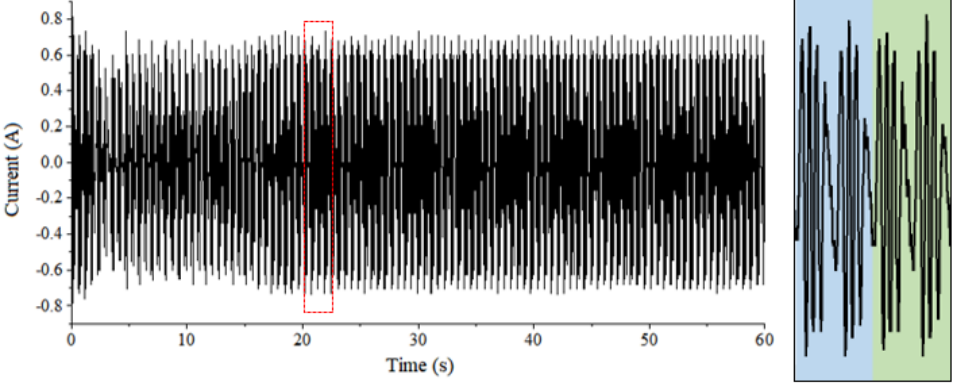
Figure 15. Current diagram (including the zoom-up of the enclosed region between 20.0 s and 22.3 s) under partial standing waves of T / T p = 1.0, h = 0.6 m.